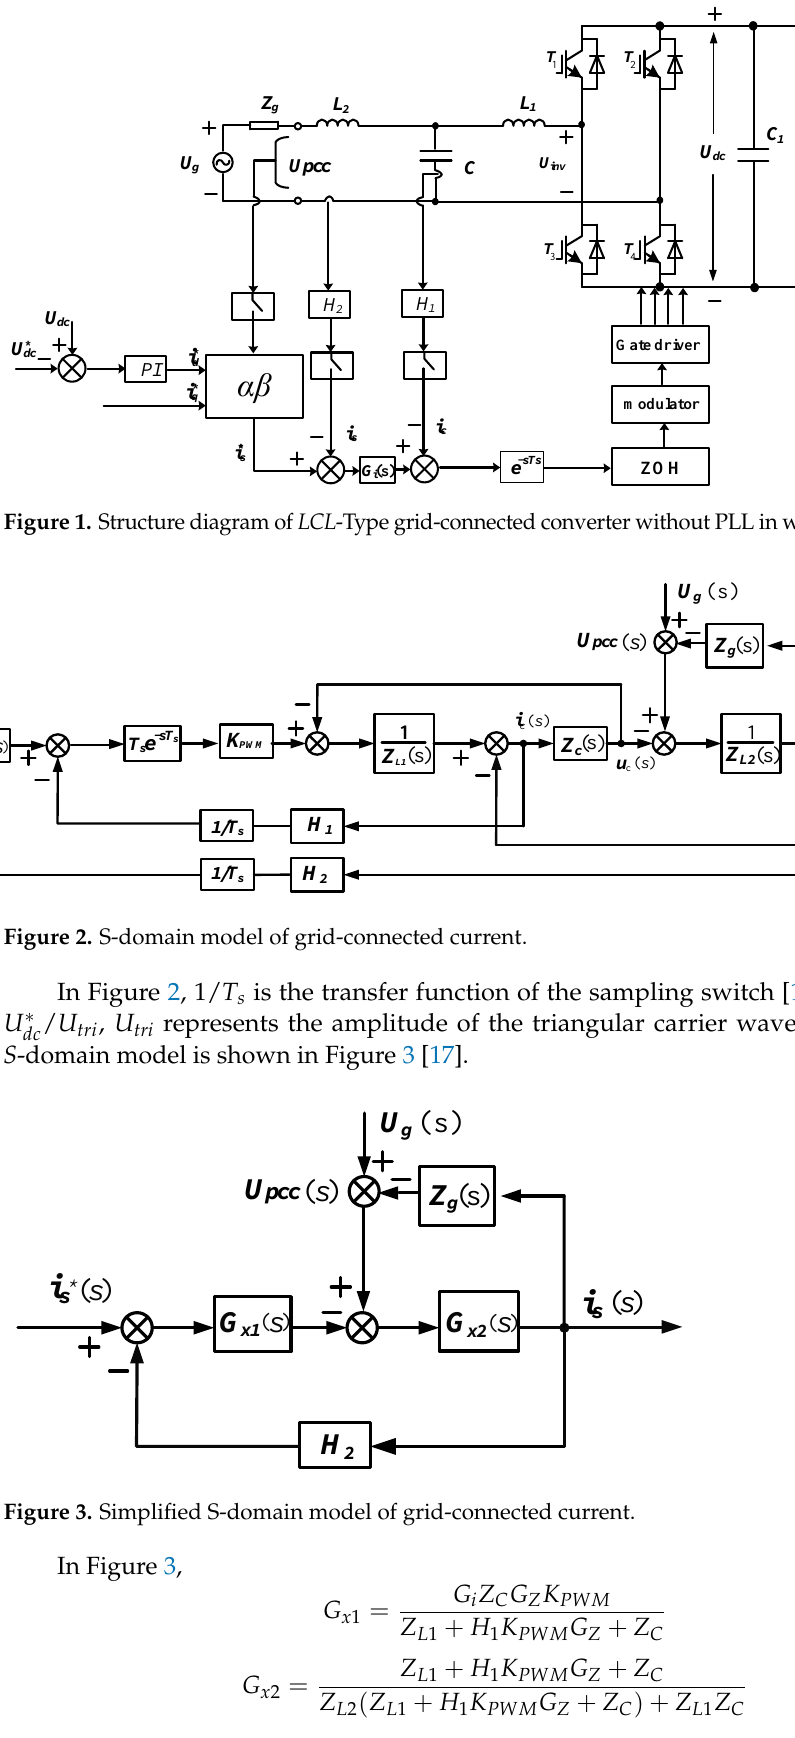
Figure 3. Simplified S-domain model of grid-connected current.